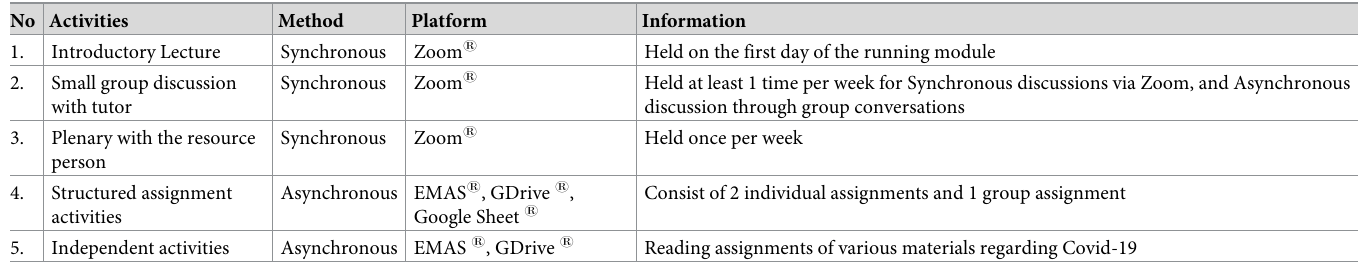
Table 1. Summary of module methods of self-isolation monitoring for coronavirus disease 19 (COVID-19) Faculty of Medicine Universitas Indonesia